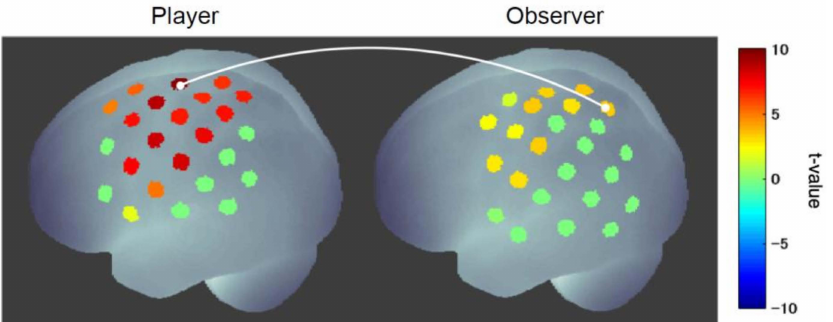
Figure 7. Functional connectivity between player and observer in cheering [74]. The connectivity be- tween the player’s motor cortex and the observer’s mirror neuron system was significantly enhanced when the player won compared to when the player